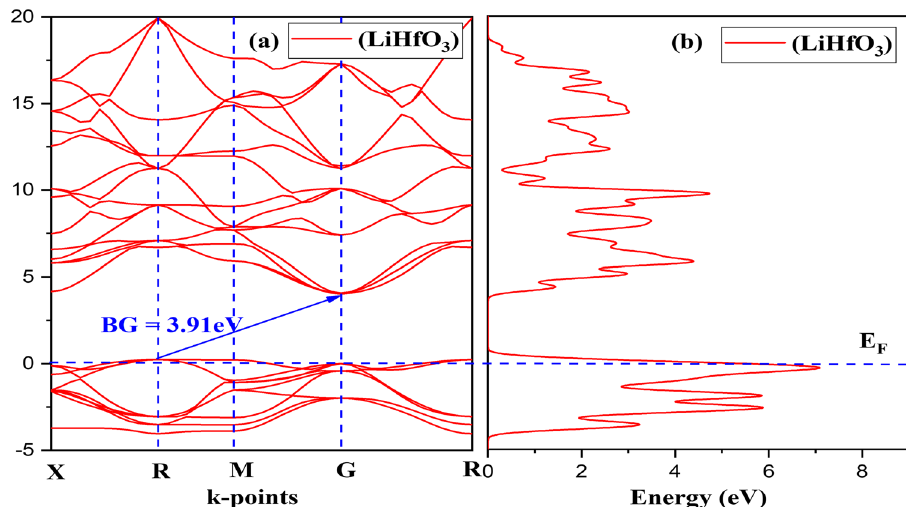
Fig. 3 Compound LiHfO